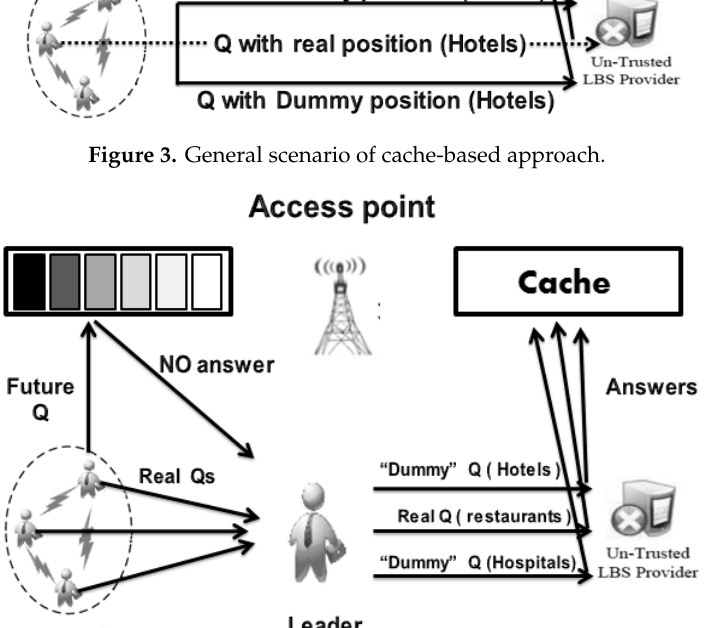
Figure 4. Proposed system model scenario.